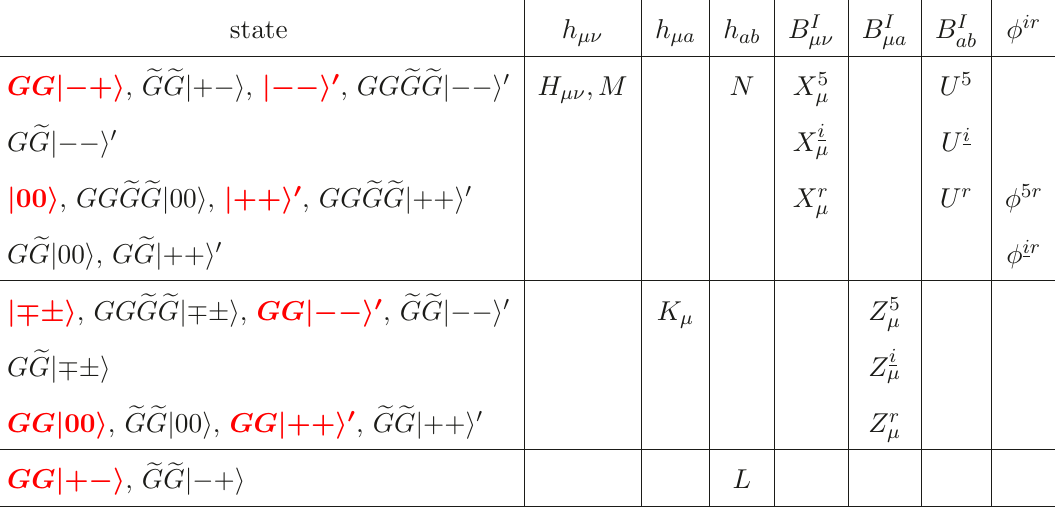
Table 1 . The fields excited in various superdescendant states. The fields in each row are described by a coupled system of equations which must be diagonalised to find the spectrum [42]. The shorthand GG means G +1 − G +2 − 1 / 2 1 / 2